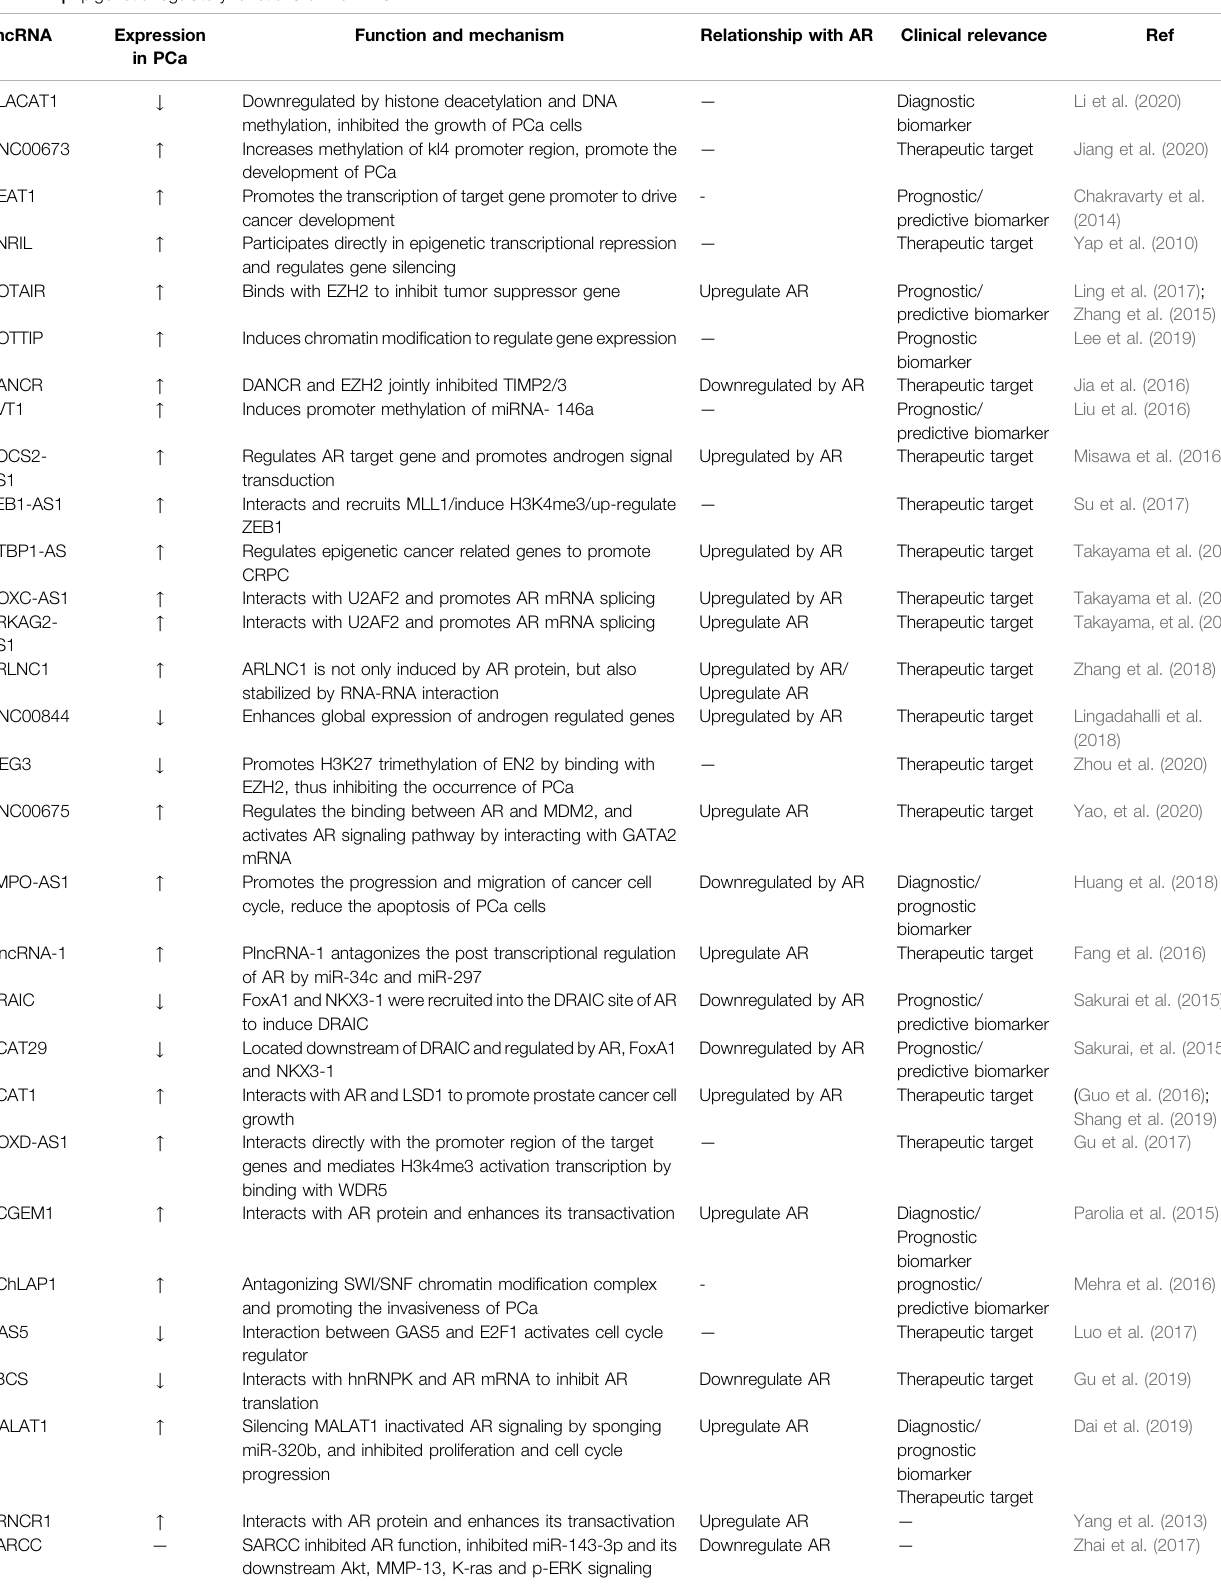
TABLE 2 | Epigenetic regulatory functions of